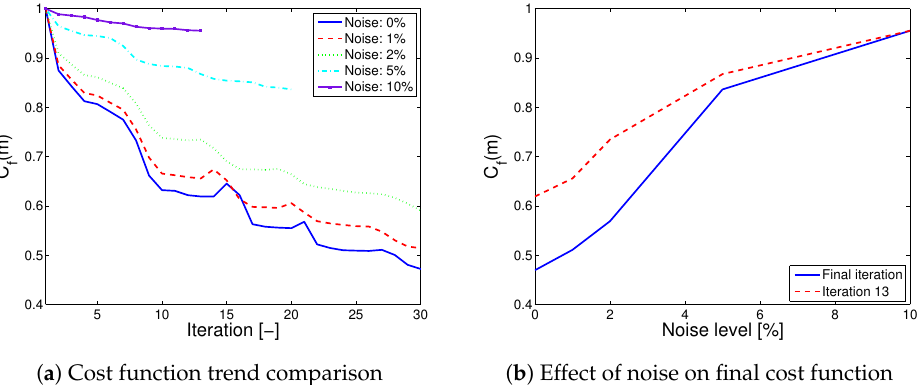
Figure 11. Cost function comparison for different noise levels: ( a ) Cost function trend showing shorter trend for higher noise levels. ( b ) Influence of noise on final cost function at the end of the simulation for each noise level, and also at end of the shortest simulation (13 iterations).